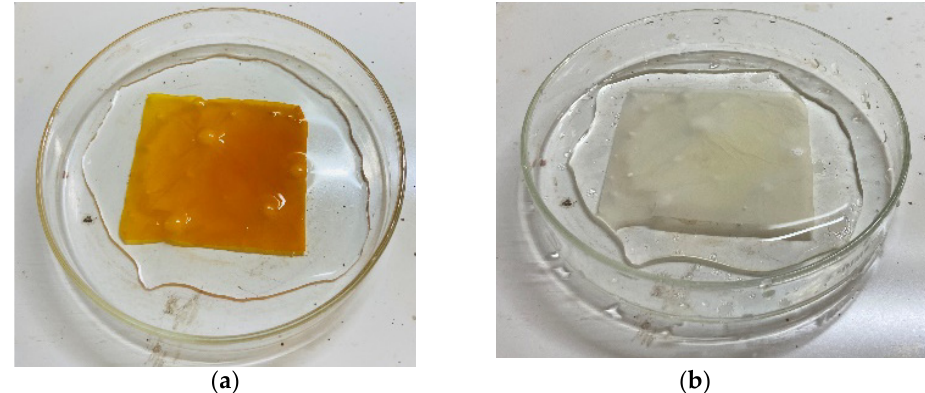
Figure 2. ( a ) Sodium hydroxide-modified polyacrylonitrile-electrospun nanofibrous membrane and ( b ) polyacrylonitrile-electrospun nanofibrous membrane functionalized with ethylenediamine.